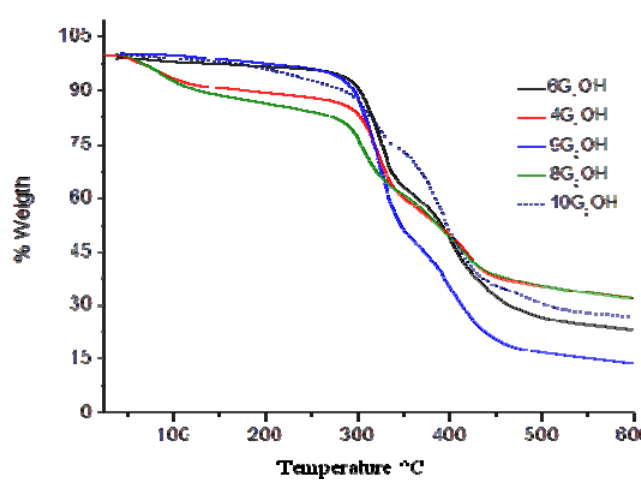
Figure 2. TGA of the obtained dendritic